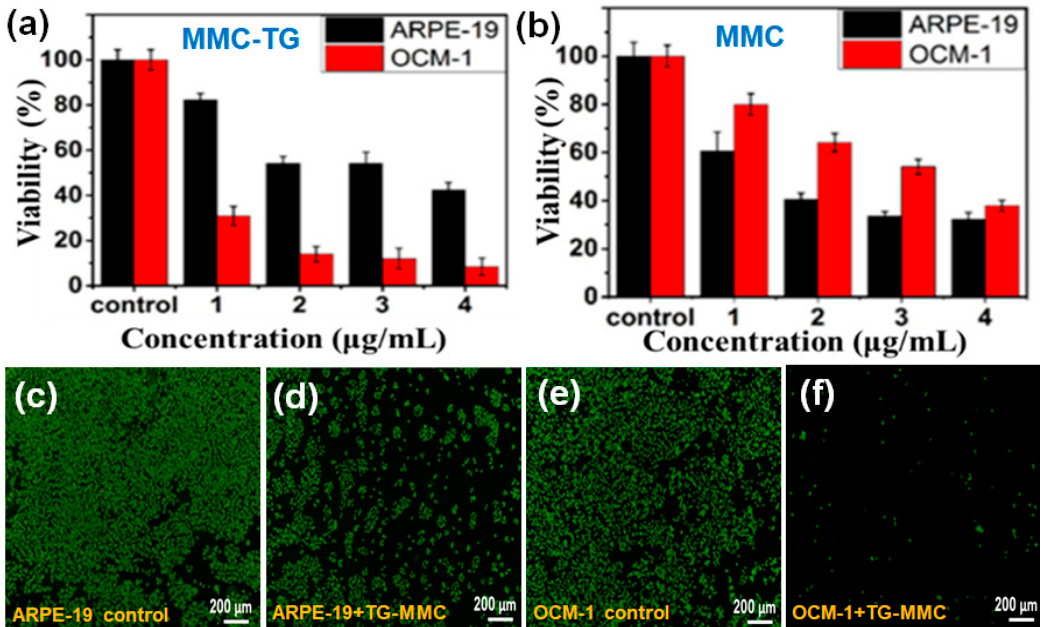
Figure 2. The cell viability of ARPE-19 and OCM-1 cells after being treated with ( a ) mitomycin C (MMC)-TG and ( b ) MMC over 72 h and fluorescence micrographs of Calcein-AM stained cells: ( c ) ARPE-19 cells, ( d ) ARPE-19 cells incubated with MMC-TG over 72 h, ( e ) OCM-1 cells, and ( f ) OCM-1 cells incubated with MMC-TG over 72 h. The concentrations in Figure 2a represent the concentrations of MMC in MMC-TG nanodrugs.